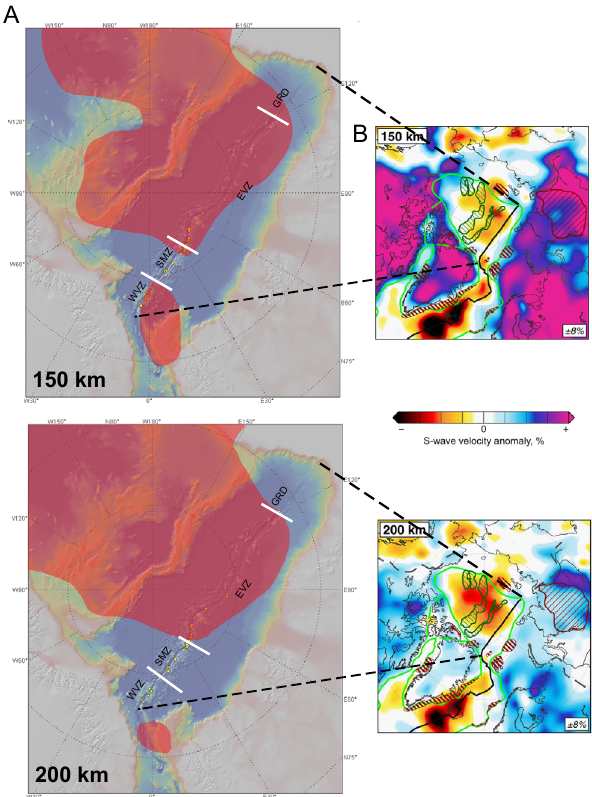
Fig. 6 The Gakkel Ridge volcanic zones and upper mantle low-velocity anomalies. A Relation between low-velocity anomalies at 200 and 150 km depth 17 and the different volcanic zones 1 as de fi ned by average spreading rates in Fig. 1. Note that the low-velocity anomaly extending across the central Arctic underlies the EVZ and the low-velocity anomaly extending from the North Atlantic is located under the WVZ. The SMZ and GRD lie between these low-velocity regions. B The AMISvArc tomographic model at 200 and 150 km from ref. 17 and Supplementary Figure 2 show that these low-velocity anomalies do not extend to shallower depths. This tomographic model is a global, shear wave velocity model of the upper mantle and crust incorporating additional data from in and around the Arctic region 17 . Further details are available in ref. 17